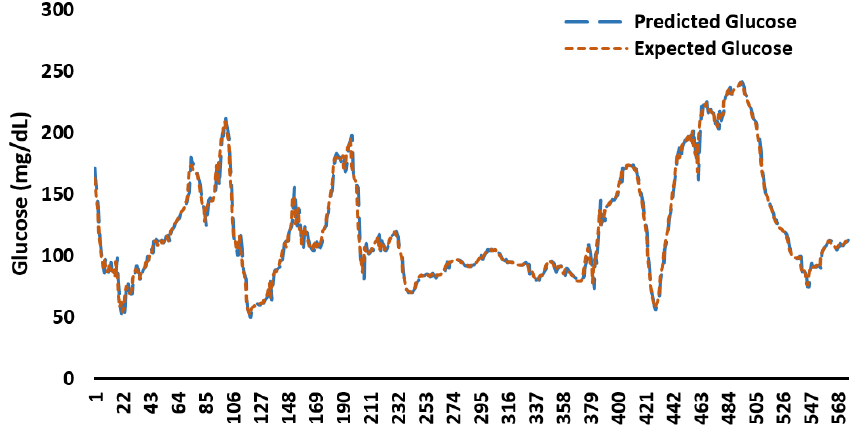
Figure A2. Comparison of expected glucose profiles with predictions from ARIMA trained on 30-day glucose data for 48 h.